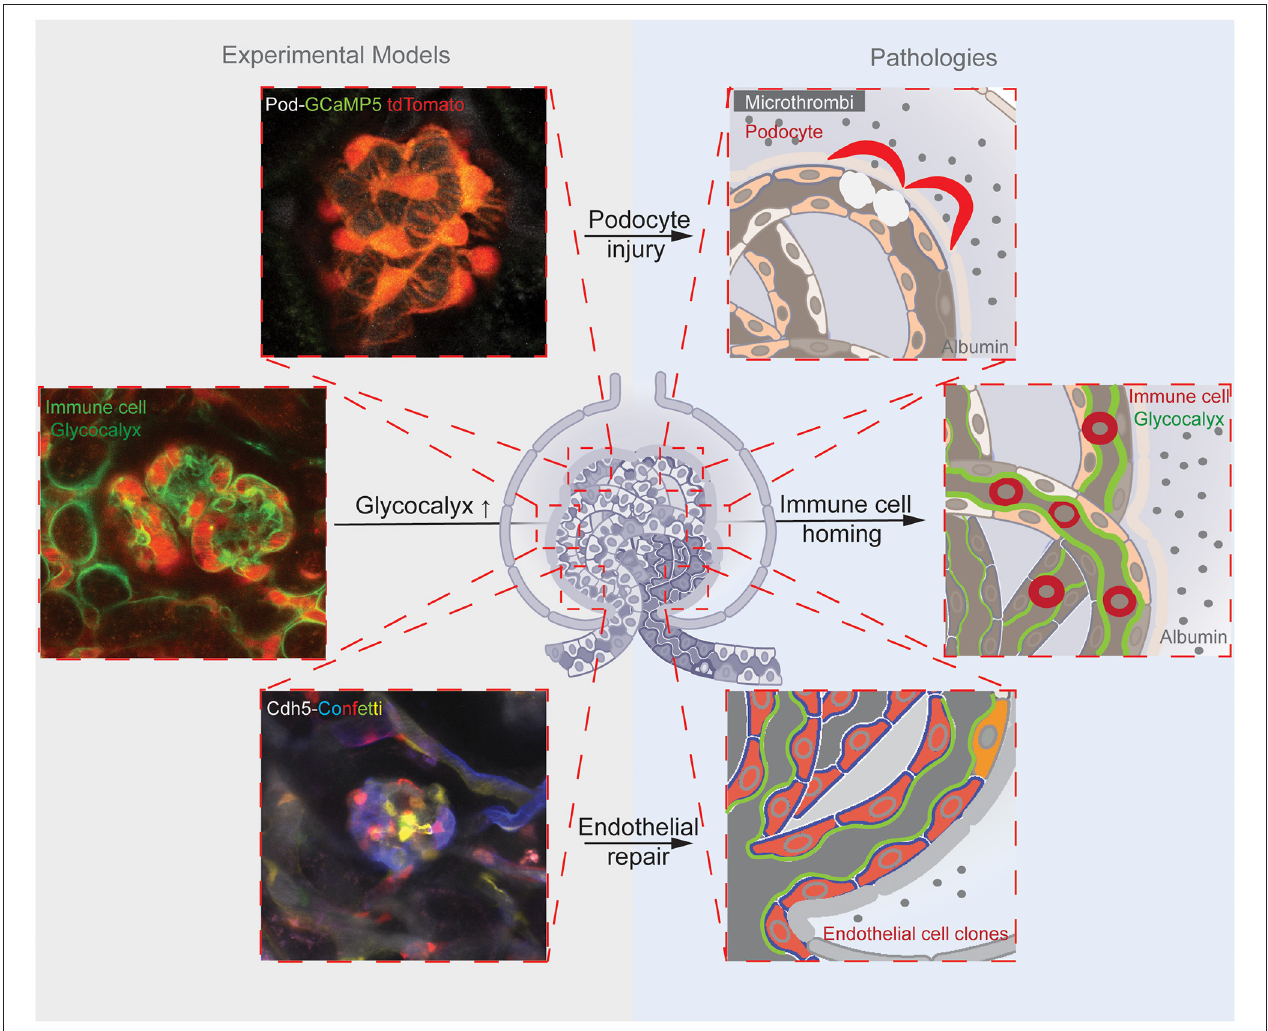
FIGURE 1 | Illustrations of the reviewed three main glomerular endothelial mechanisms (shown in the top, center, and bottom rows). Corresponding representative images of the experimental models (on the left) that were applied to study the pathological mechanisms (schematics on the right). The top panels illustrate the endothelial injury-induced formation of microthrombi and hemodynamic and mechanical GFB alterations leading to podocyte damage, and mice with podocyte-specific expression of the calcium reporter GCaMP5 (green)/tdTomato (red). The center panels show the endothelial surface layer (glycocalyx)-mediated glomerular homing of immune cells, and the labeling of the glomerular endothelial glycocalyx with FITC-WGA and immune cells with anti-CD44-Alexa Fluor 488 antibodies (green) and the circulating albumin with Alexa Fluor 594 (red). The bottom panels demonstrate clonal remodeling and functional regeneration of the glomerular endothelium by local endothelial precursor cells, and the genetic Cdh5-Confetti mouse model with multicolor fluorescent reporter (CFP/GFP/YFP/RFP, a.k.a. Confetti) expression in